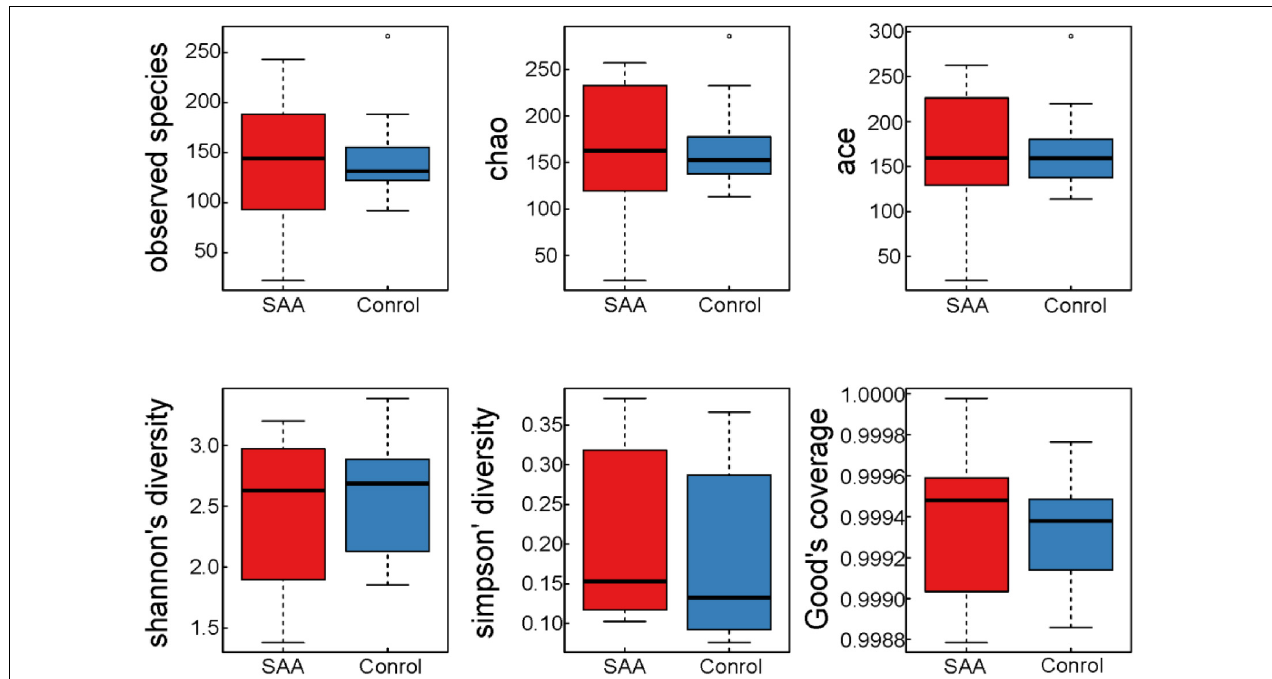
FIGURE 2 | Boxplots of indices of the alpha diversity of the intestinal microbiota in the SAA and control groups.